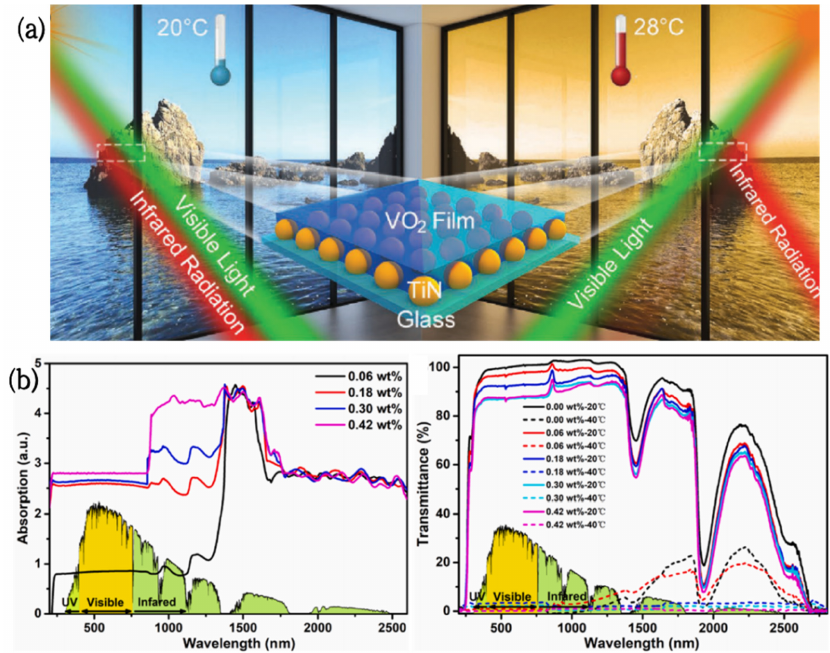
Figure 5. ( a ) Schematic diagram of a VO 2 /TiN smart window [86]. ( b ) UV-Vis-NIR absorption and transmission spectra of PNIPAm hydrogels containing different levels of PDAPs at 20 °C and 40 °C [87].